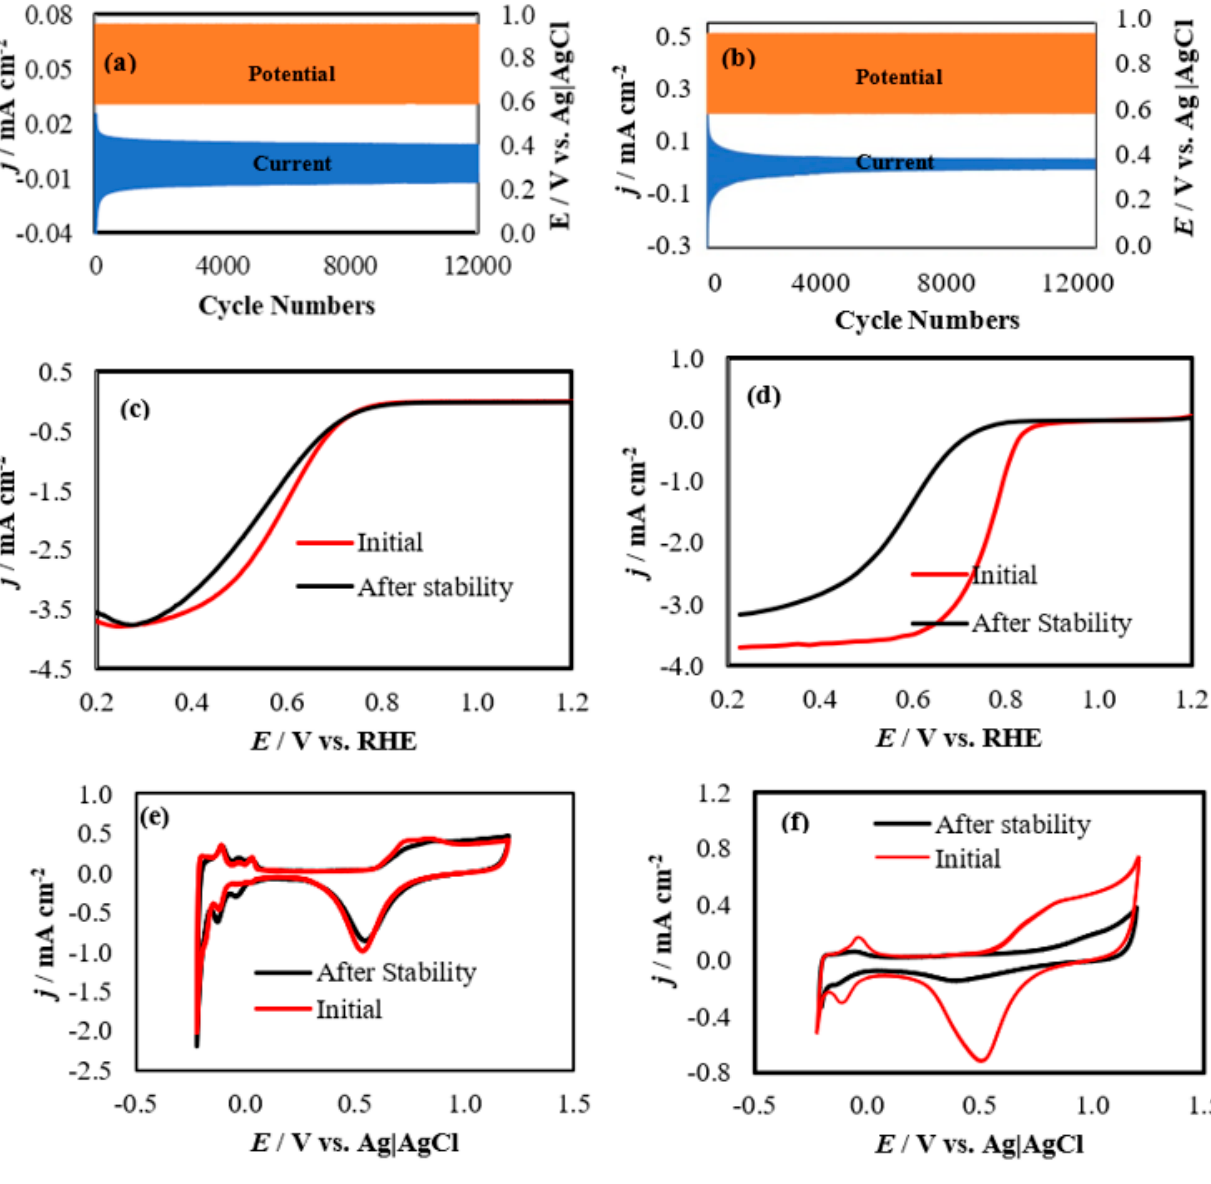
Figure 5. AST studies obtained using the rotating disk electrodes with ( a ) Pt/Ti 9 O 17 catalyst and ( b ) state-of-the-art Pt/C catalyst carried out in O 2 -saturated 0.5 M H 2 SO 4 solution. Comparison of ORR polarization curves at ( c ) Pt/Ti 9 O 17 catalyst and ( d ) state-of-the-art Pt/C catalyst. Comparison of CVs at ( e ) Pt/Ti 9 O 17 catalyst and ( f ) state-of-the-art Pt/C catalyst before and after stability